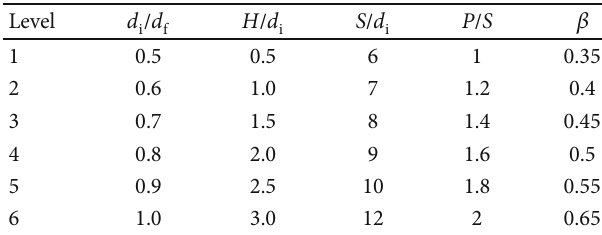
Figure 22: In fl uence of hole arrangement on cooling e ffi ciency distribution. Table 3: Orthogonal